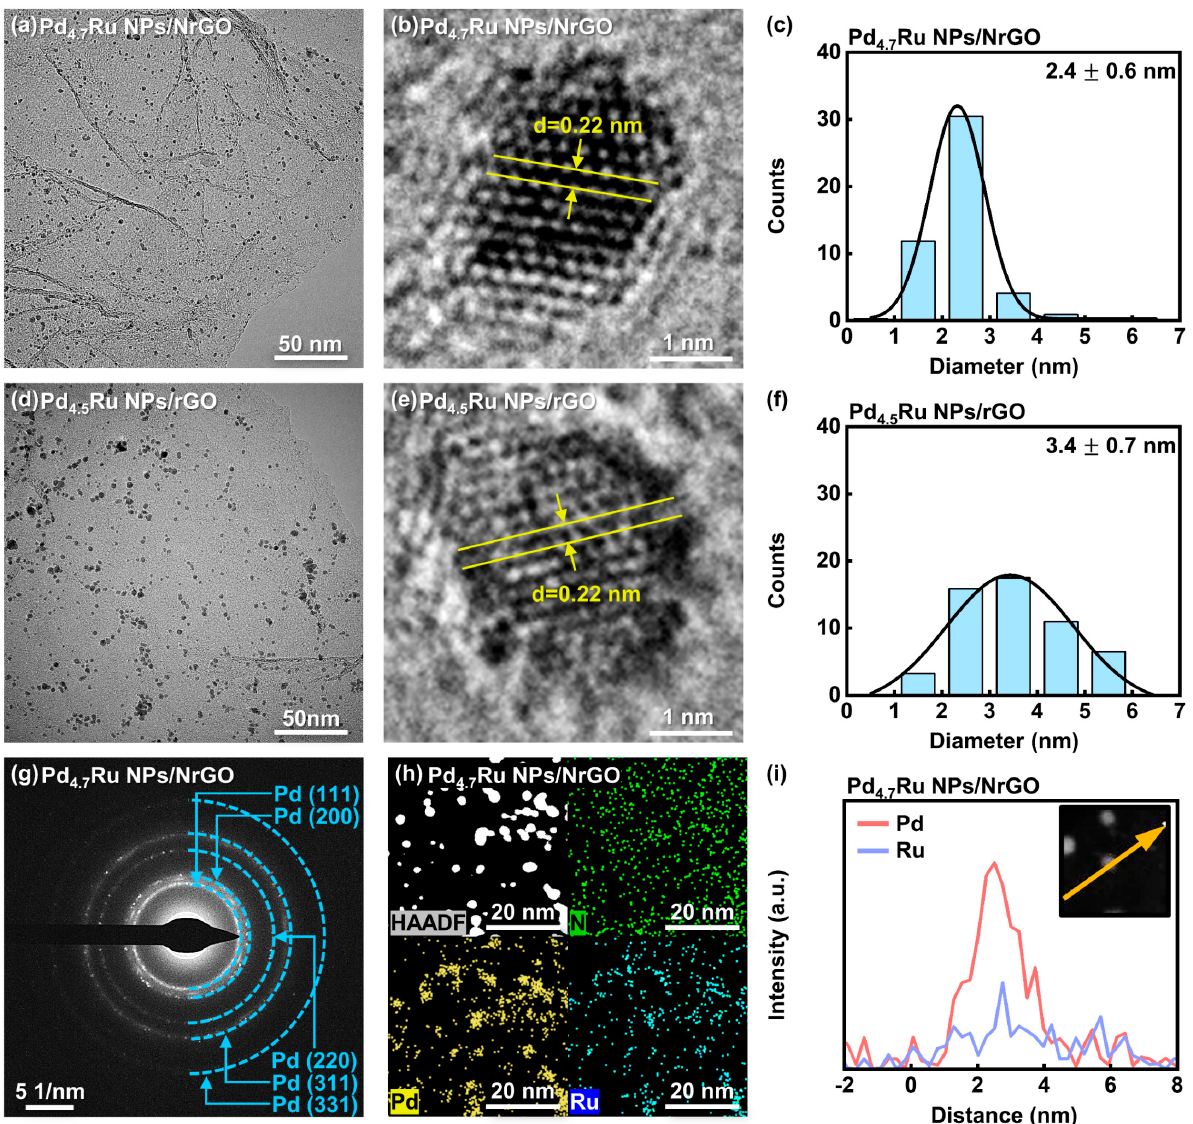
Figure 2. TEM and high-resolution image of the ( a , b ) Pd 4.7 Ru NPs/NrGO and ( d , e ) Pd 4.5 Ru NPs/rGO and the correspond- ing particle size distribution histograms of the ( c ) Pd 4.7 Ru NPs/NrGO and ( f ) Pd 4.5 Ru NPs/rGO. ( g ) SAED patterns of the Pd 4.7 Ru NPs/NrGO. ( h ) EDS mapping images and ( i ) line scanning of the Pd 4.7 Ru NPs/NrGO (Inset: HAADF images of the Pd 4.7 Ru NPs/NrGO in line scanning area).